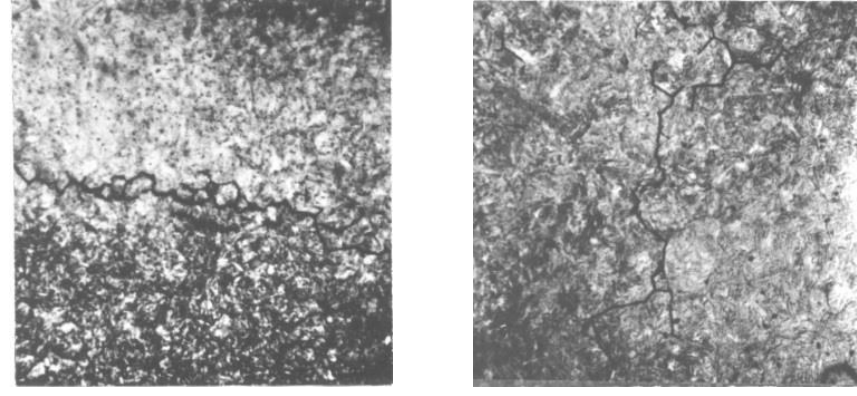
Fig. 1. Microstructure of a piston pin cemented layer made of 12HN3A steel, restored by thermoplastic expansion